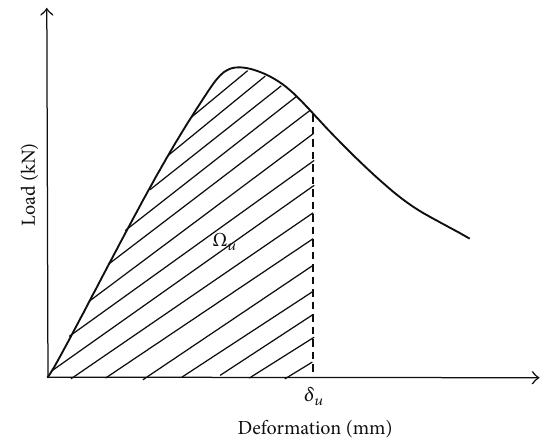
Figure 4: The calculation of equivalent compressive strength.